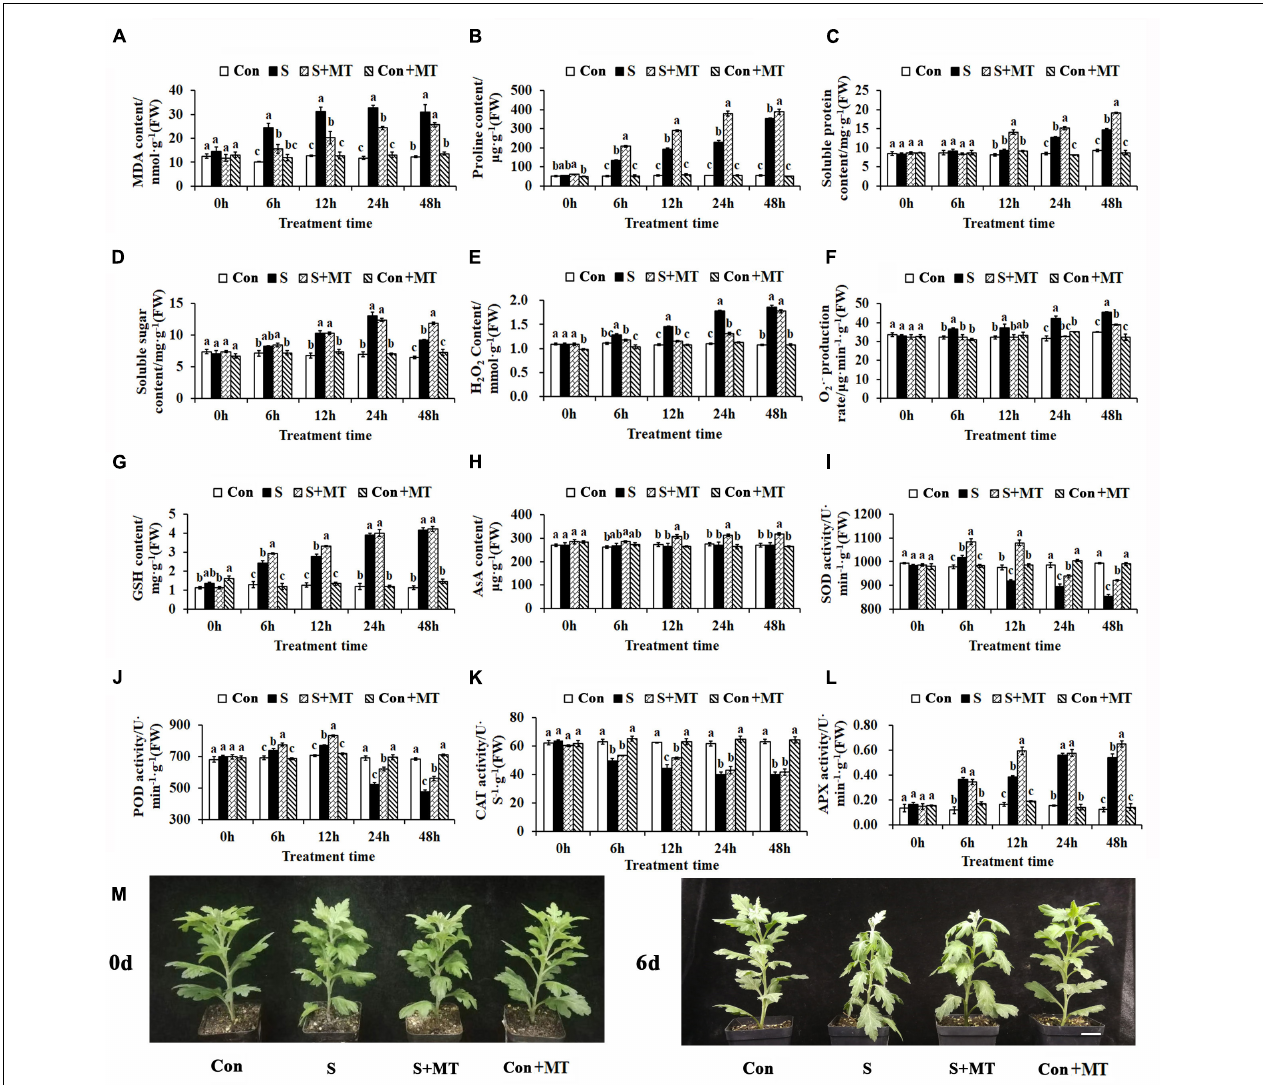
FIGURE 1 | Physiological responses of chrysanthemum seedlings under heat stress. (A–E) The content of MDA (A) , proline (B) , soluble protein (C) , soluble sugar (D) , and hydrogen peroxide (E) . (F) The generation rate of superoxide anion free radicals. (G) The content of reduced glutathione. (H) The ascorbic acid content. (I–L) The activities of SOD (I) , POD (J) , CAT (K) , and APX (L) . (M) Phenotypes after 6 days of heat stress treatment. Con, control; S, heat stress; S + MT, heat stress with exogenous melatonin treatment; Con + MT, control with exogenous melatonin treatment. Error bars indicate SE ( n = 3). Duncan’s multiple range test was used to analyze significant differences. Different letters indicate significant differences at P <